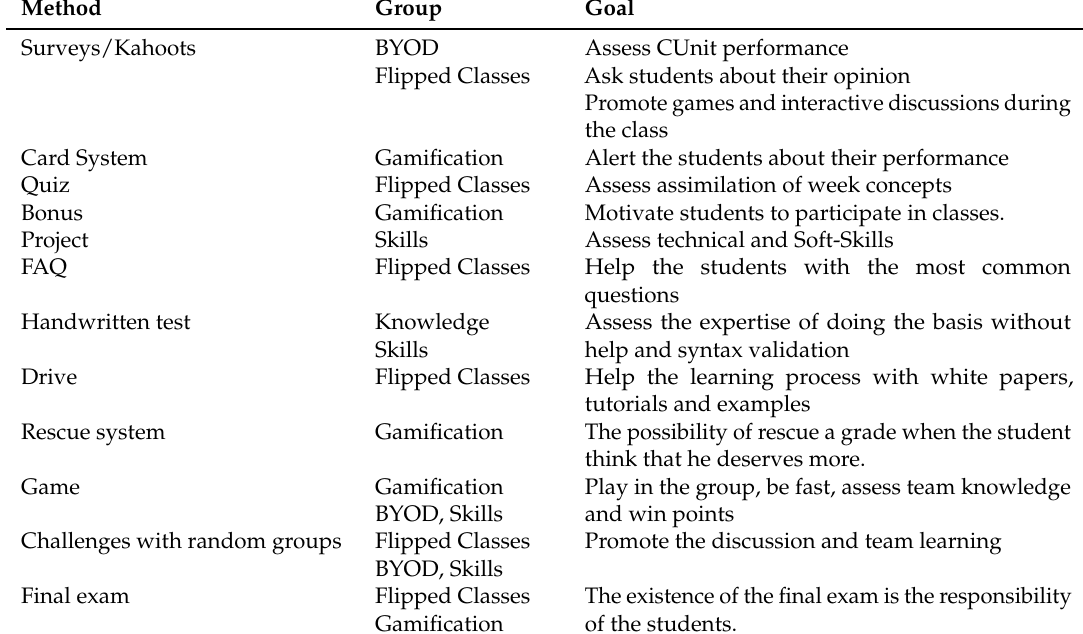
Table 7. Learning and assessment methods.